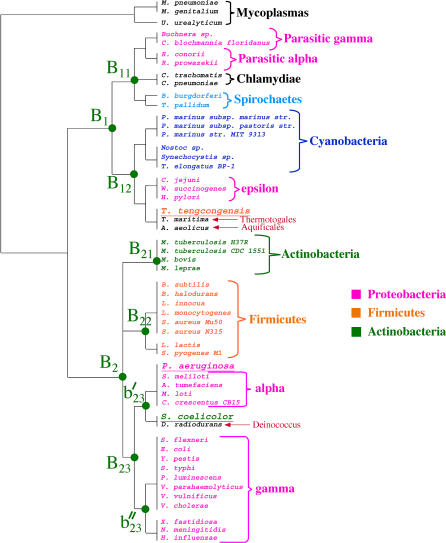
Bacterial Branch
Bacteria subtree (see Materials and Methods), based on the restriction of the Jaccard scores matrix to the lines corresponding to bacterial species.